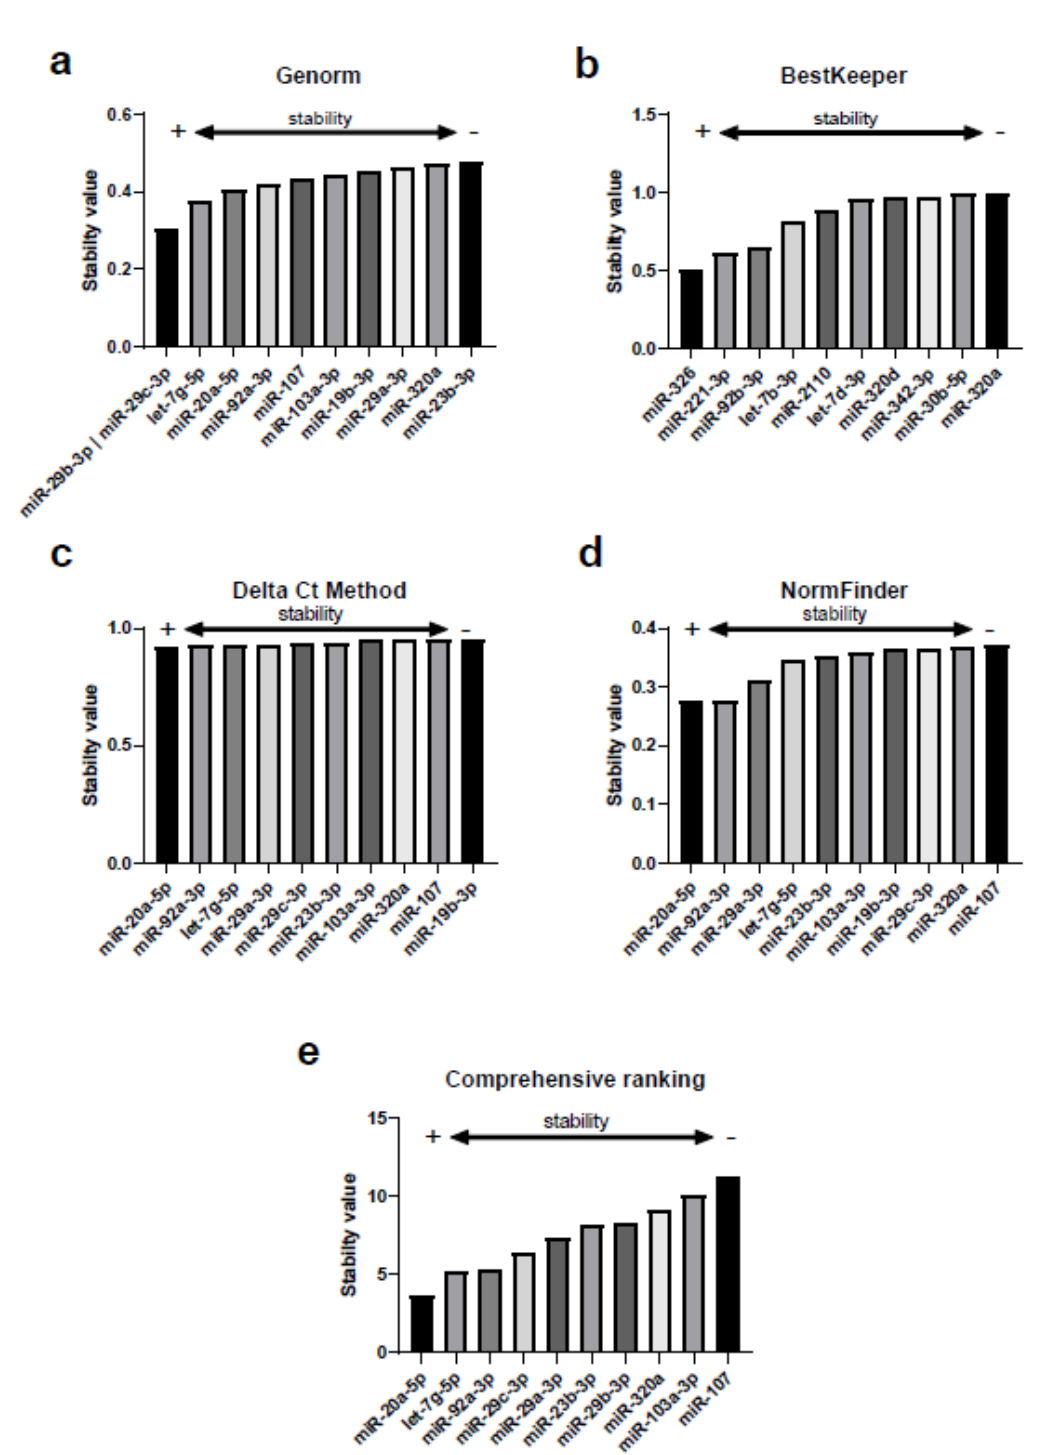
Figure 2. Selection of candidate miRNA normalizers and analysis of their stability conducted with the comprehensive tool RefFinder. Each graph represents the best 10 reference miRNAs selected by each algorithm: ( a ) Genorm, ( b ) BestKeeper, ( c ) Delta Ct method, ( d ) NormFinder and ( e ) Comprehensive raking. The lower the stability value, the higher the stability of each miRNA.